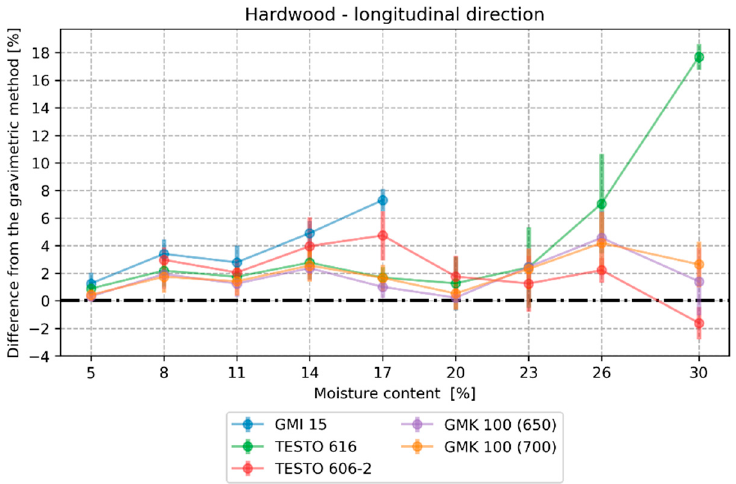
Figure 2. Comparison of average values of differences from the gravimetric method in the longitudinal direction of beech wood using selected moisture meters GMI 15, GMK 100, Testo 616, and Testo 606-2 in different moisture conditions and GMI 100 at different instrument settings of 650 kg/m 3 (650) and 700 kg/m 3 (700).